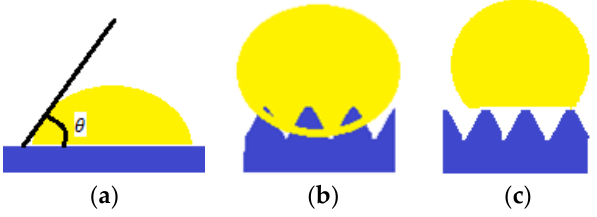
Figure 1. ( a ) Young wetting regime; ( b ) Wenzel wetting regime; ( c ) Cassie wetting regime.